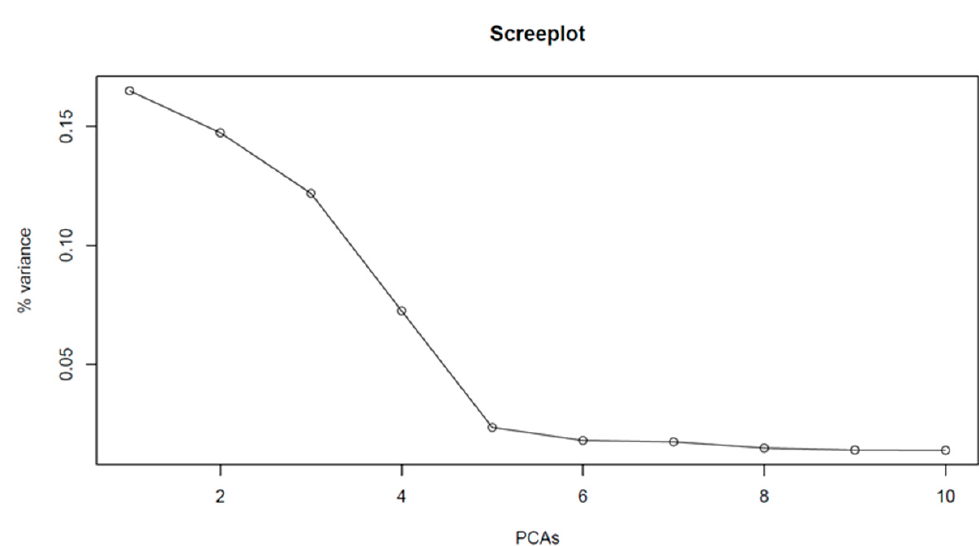
Figure 3. Principal component analysis on the 2256 haploblocks of 58 wheat genotypes. Scree plot of the percentage of the variance explained by the first 10 PCs. Table 1. Detailed information about the haploblock-based map for 58 genotypes of wheat based on DArT markers. Detailed data showed that genome A consisted of 706 HBs. Genome B was built of 803 HBs and the lowest number of HBs was identified on genome D (Table 1).